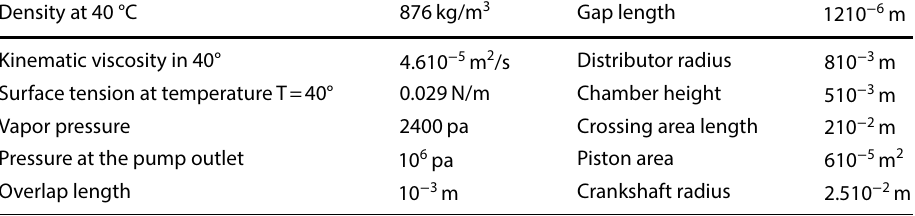
Density at 40 °C